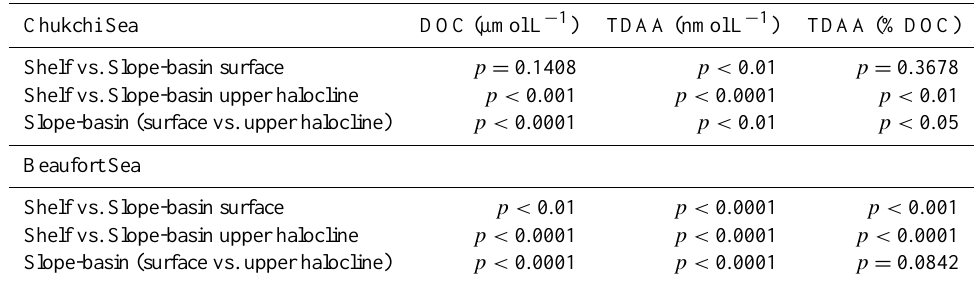
Fig. 5. DOC-normalized yields of total dissolved amino acids in (a) shelf, (b) slope, and (c) basin waters of the Chukchi Sea (SBI 2002, SBI 2004) and Beaufort Sea (CFL 2008, MAL 2009). Table 2. Statistical comparisons of the concentrations of DOC and TDAA, and TDAA yields in the Chukchi and Beaufort Seas (Mann- Whitney U